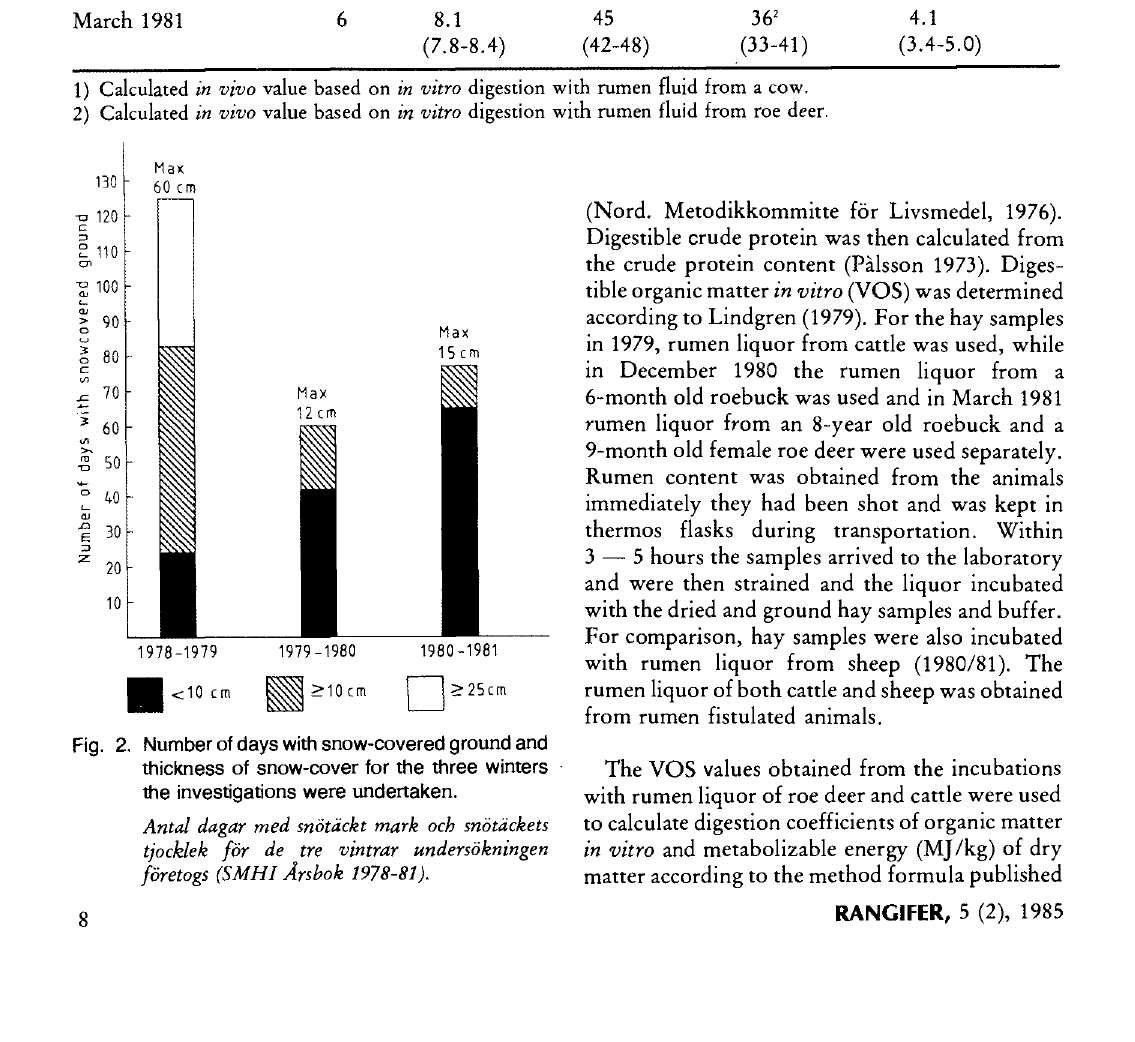
Fig. 2. Number of days with snow-covered ground and thickness of snow-cover for the three winters the investigations were undertaken. Antal dagar med snbtdckt mark och snotackets tjocklek for de tre vintrar undersokningen foretogs (SMHlArsbok